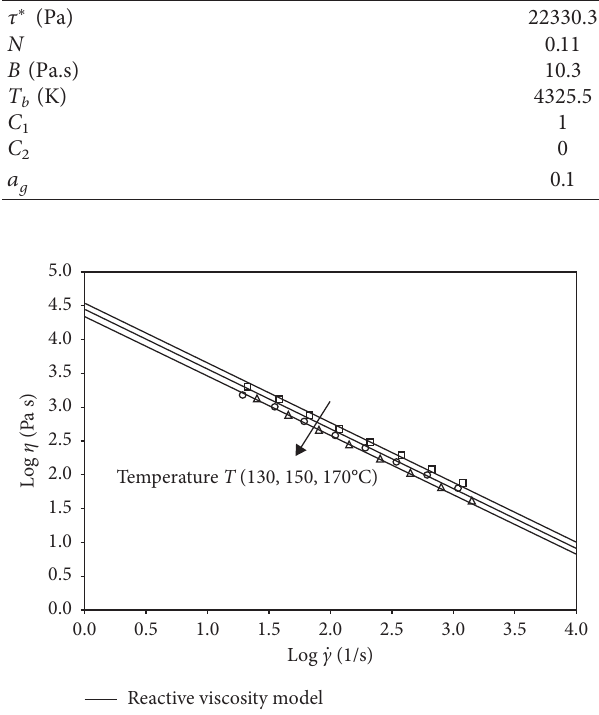
Figure 2: Experimental data of viscosity, evaluated at the tem- peratures of 130, 150, and 170 ° C (open symbols) and the respective curves generated by the reactive viscosity model